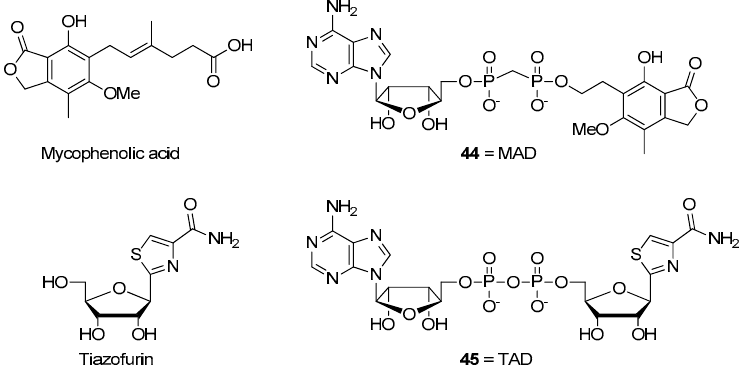
Figure 9. Some currently known inhibitors of IMPDH used in clinic and their derivatives [66].